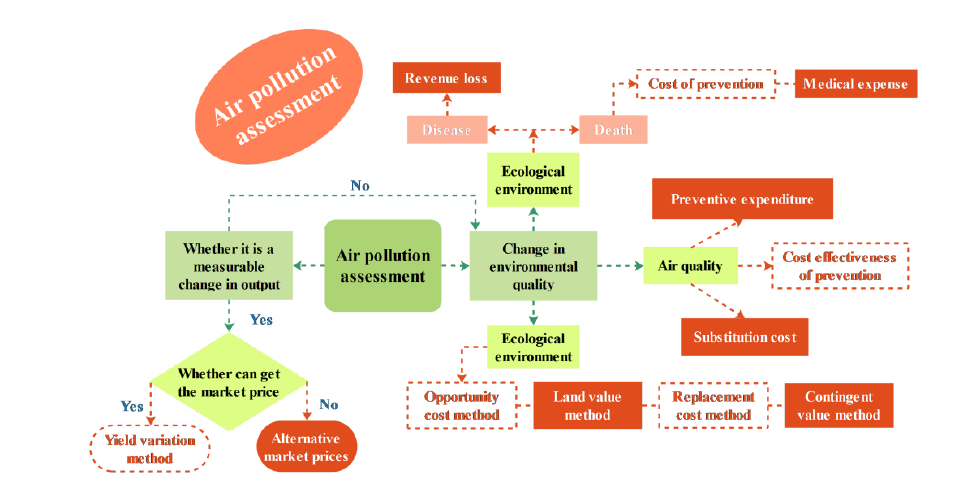
Figure 2. The flowchart of the assessment methods. Table 1. List of assessment methods.